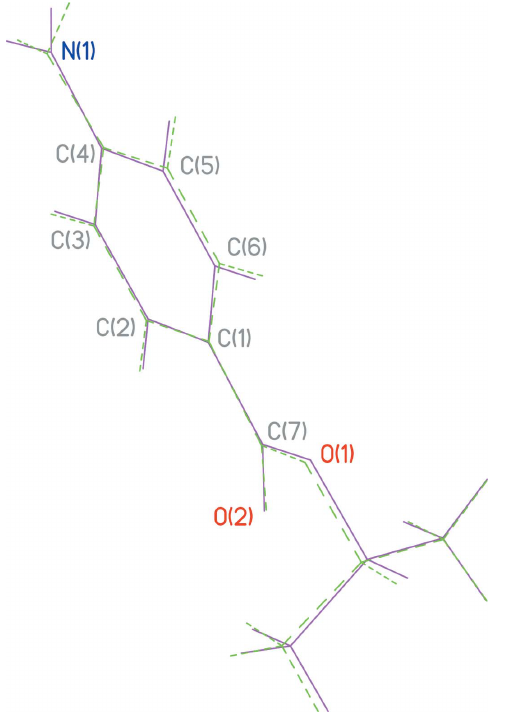
Figure 2 An overlap of molecules A and B centered on the phenyl rings of both molecules showing the differences in both conformers involving the conformations of both the NH 2 and i -propyl substituents.